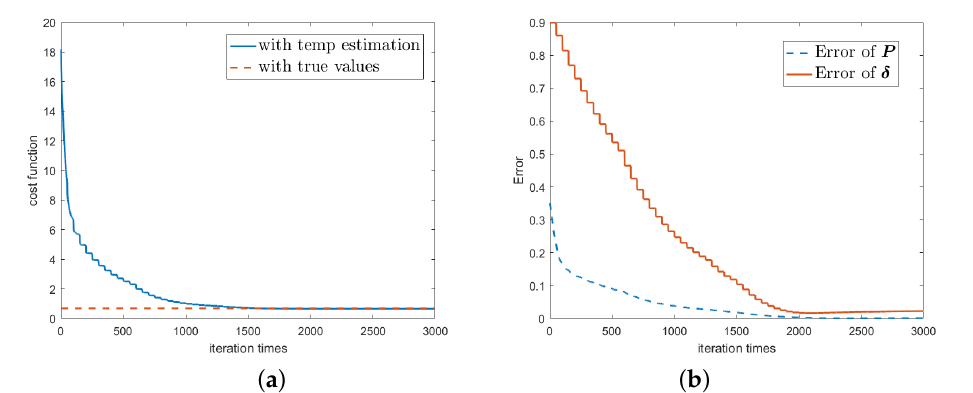
Figure 2. The convergence behavior of GSE − SC. ( a ) Cost function; ( b ) Estimation